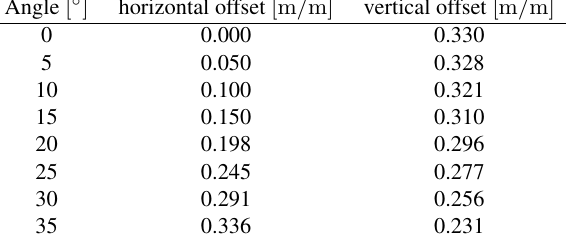
Table 1. Correction coefficients for horizontal and vertical direction for different angles of incidence.